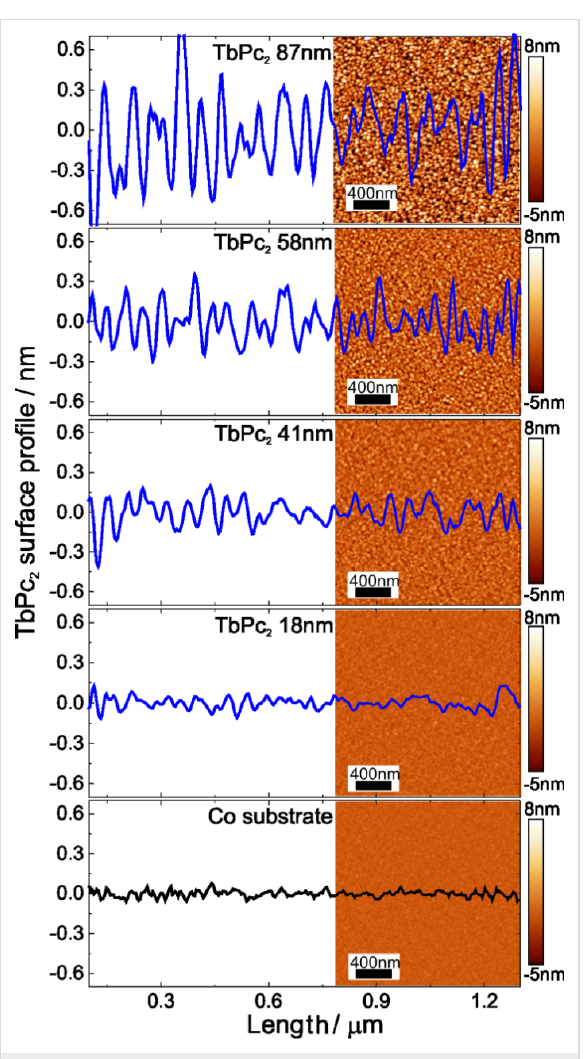
Figure 4: AFM topography characteristics of TbPc 2 thin films. Line scan profiles and AFM surface images for TbPc 2 films of 18, 41, 58 and 87 nm deposited on a 25 nm thick Co film.